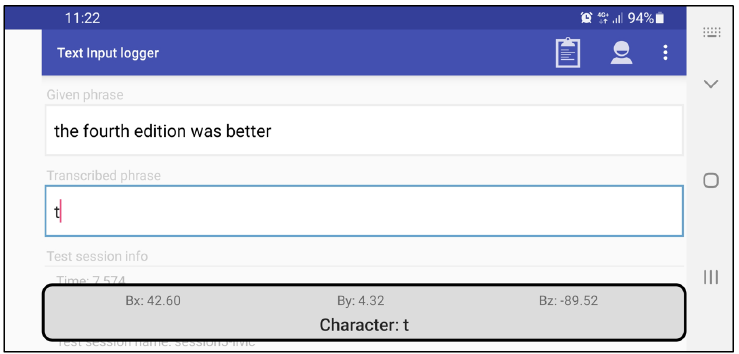
Figure 4. Text Input Logger—Android application used for text entry empirical research.